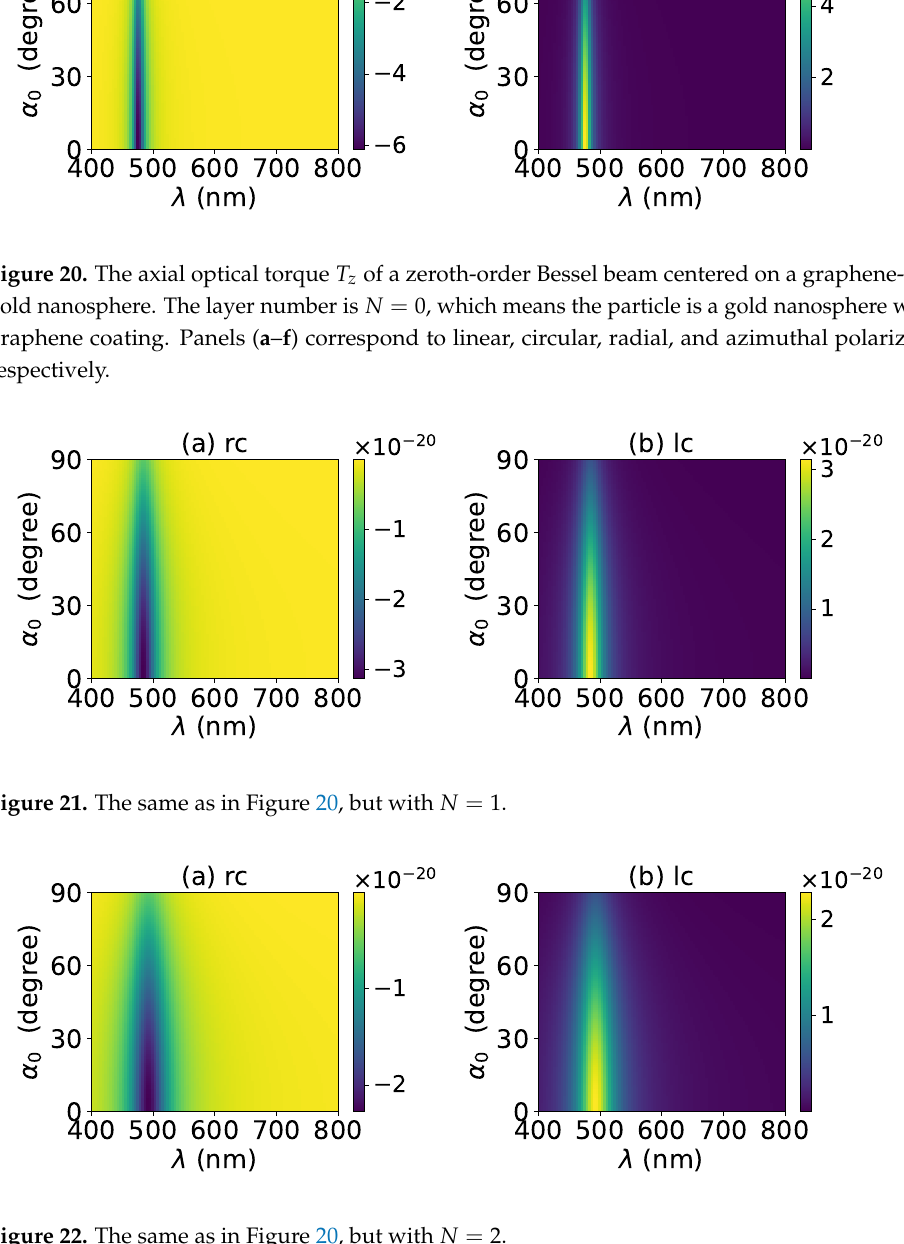
Figure 22. The same as in Figure 20, but with N =